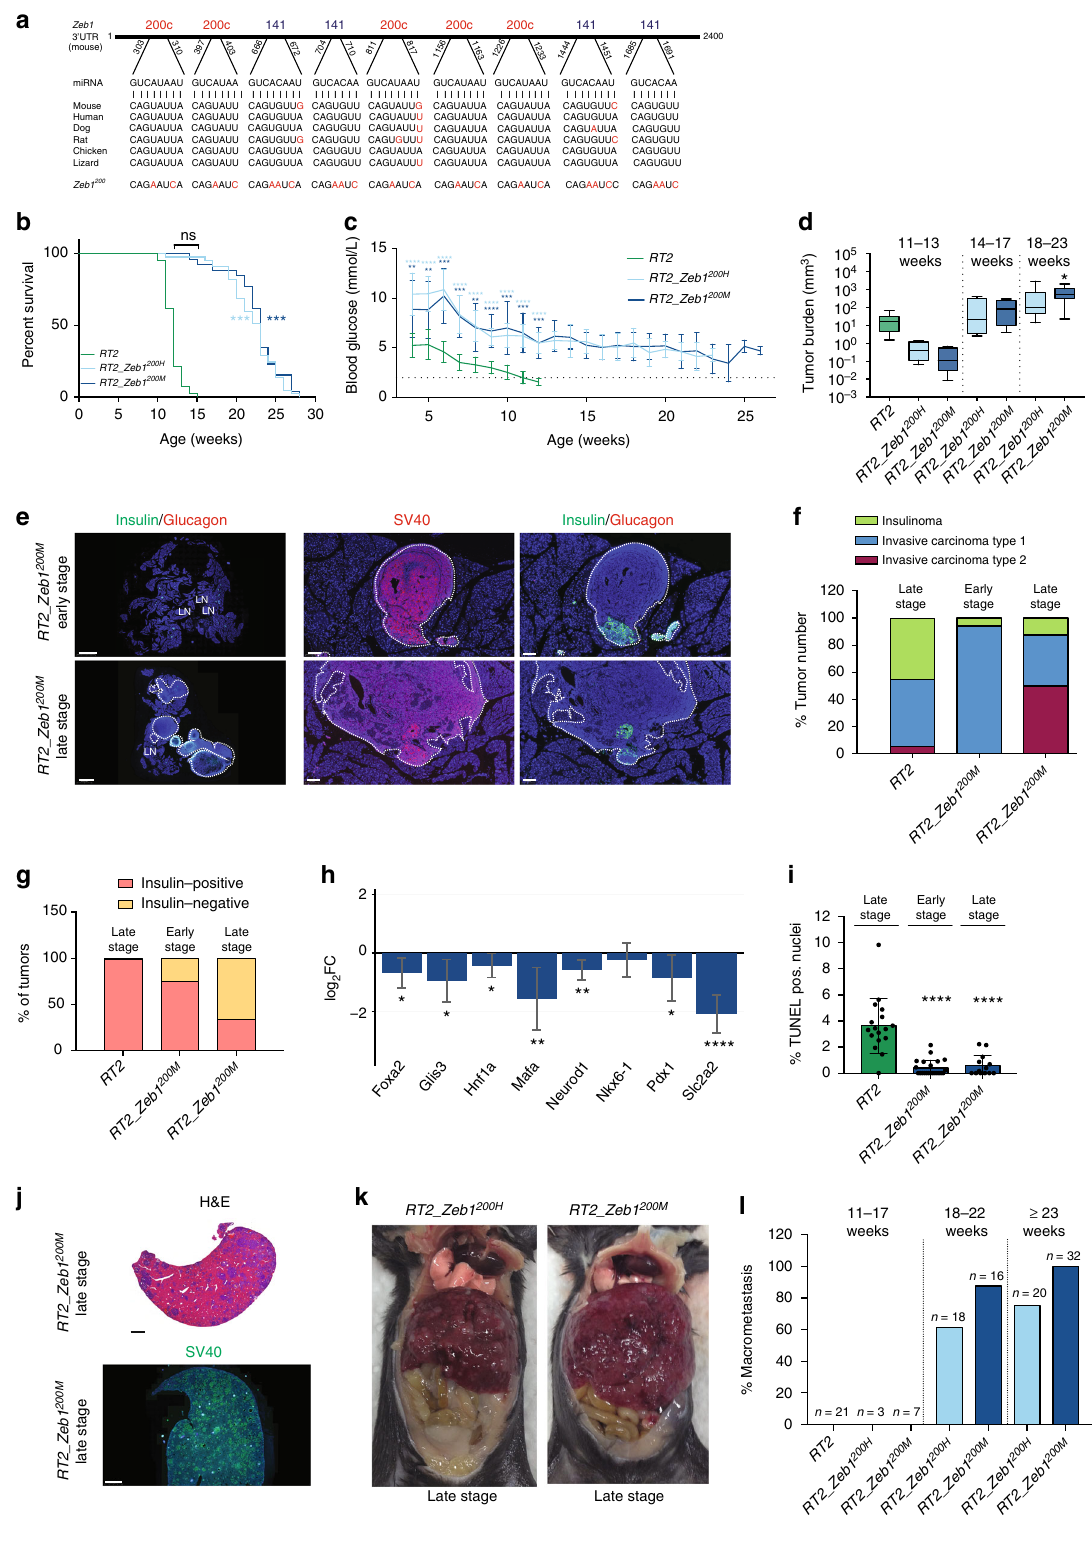
(Fig. 3e, f). Interestingly, Zeb1 target genes were signi fi cantly further downregulated in RT2_Zeb1 200M mice compared to RT2_DKO mice (Supplementary Figure 3c). Heat-map analysis also shows that Zeb1 target genes were highly differentially expressed in RT2_Zeb1 200M vs. RT2 islets and more similar